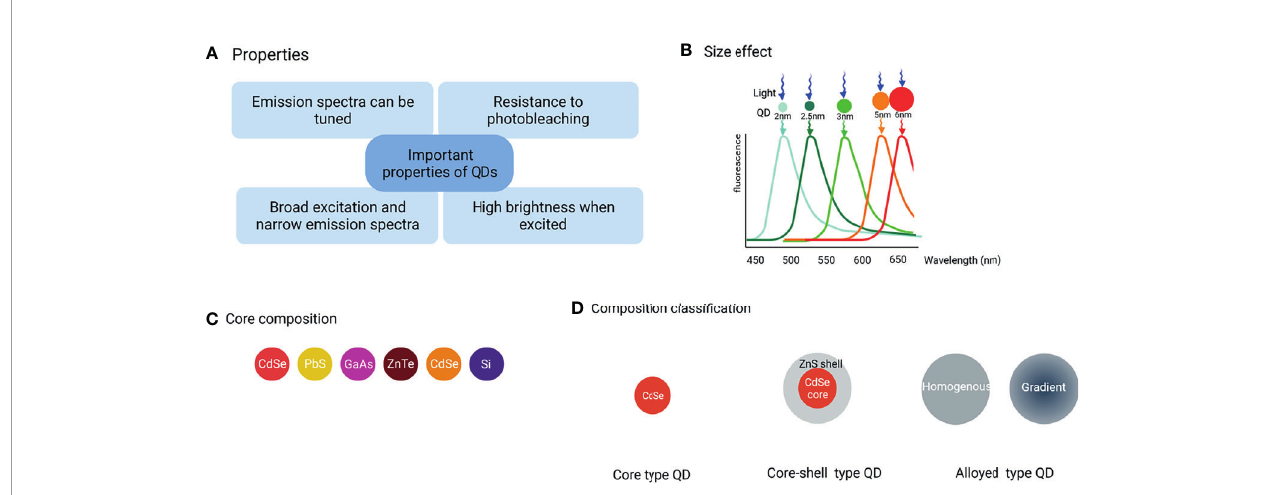
FIGURE 1 | Classi fi cation of QDs and their main properties. (A) The important properties of QDs, (B) Under single-source excitation, a range of well-separated hues can be achieved by adjusting the size and shape of QDs, (C) The commonly used core composition of QDs, (D) Three major QD types are classi fi ed by composition and